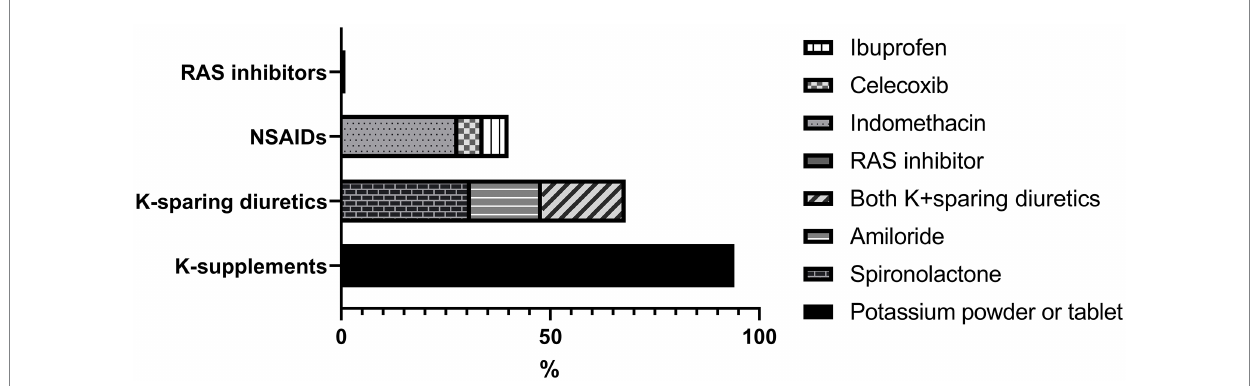
FIGURE 2 Medical treatment at the last follow-up. RAS, Renin-angiotensin system; NSAIDs, non-steroidal anti-inflammatory drugs; K, potassium.